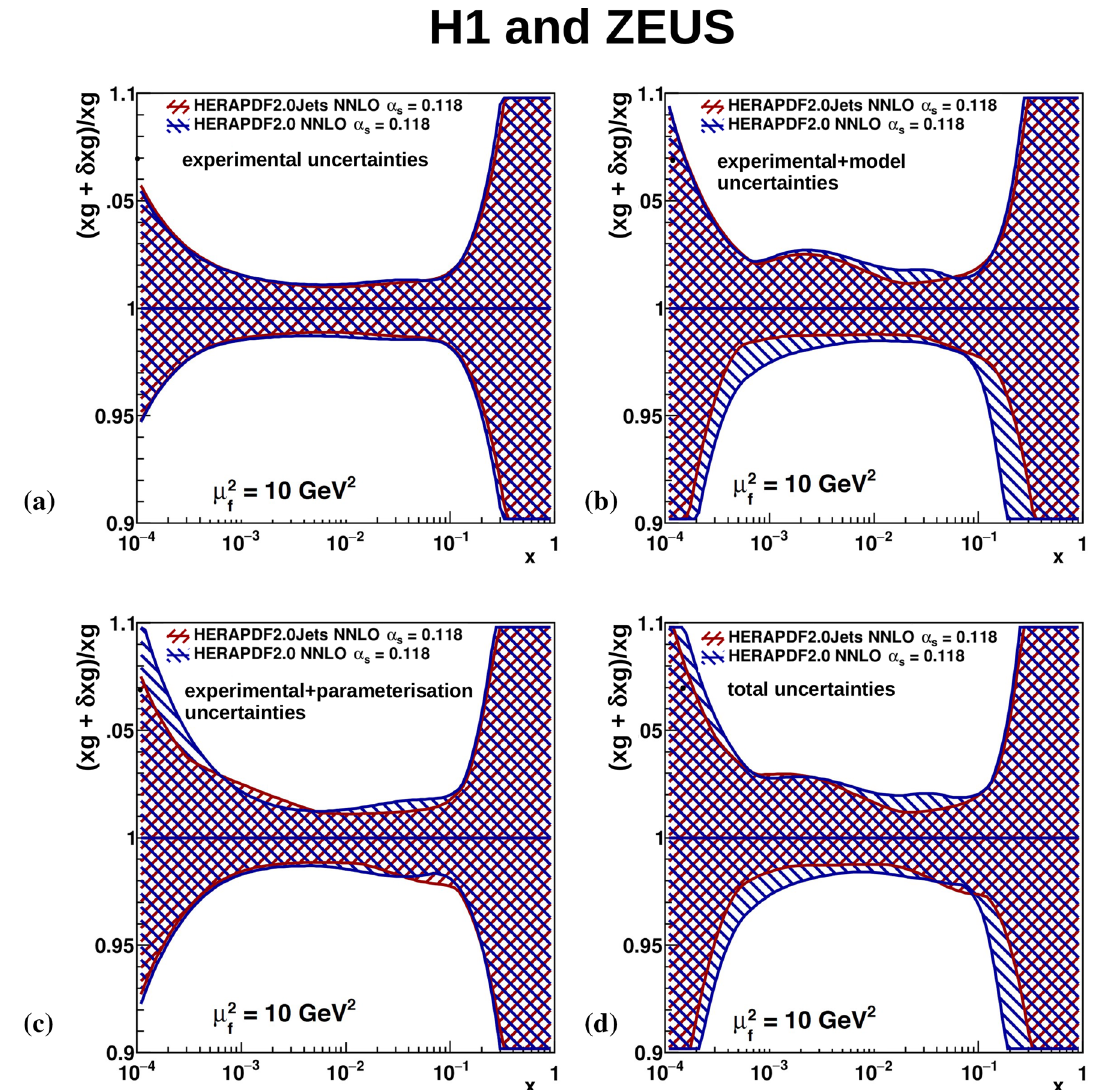
Fig. 8 Comparison of the normalised uncertainties on the gluon PDFs of HERAPDF2.0Jets NNLO and HERAPDF2.0 NNLO, both for α ( M 2 ) = 0 . 118 and at the scale μ 2 = 10GeV 2 , for a experimental s Z f